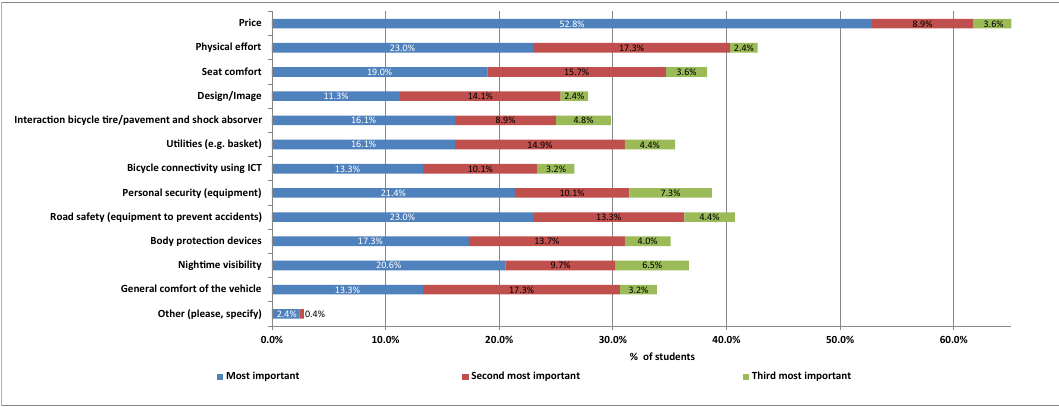
Fig. 4 Most important attributes of electric bicycles